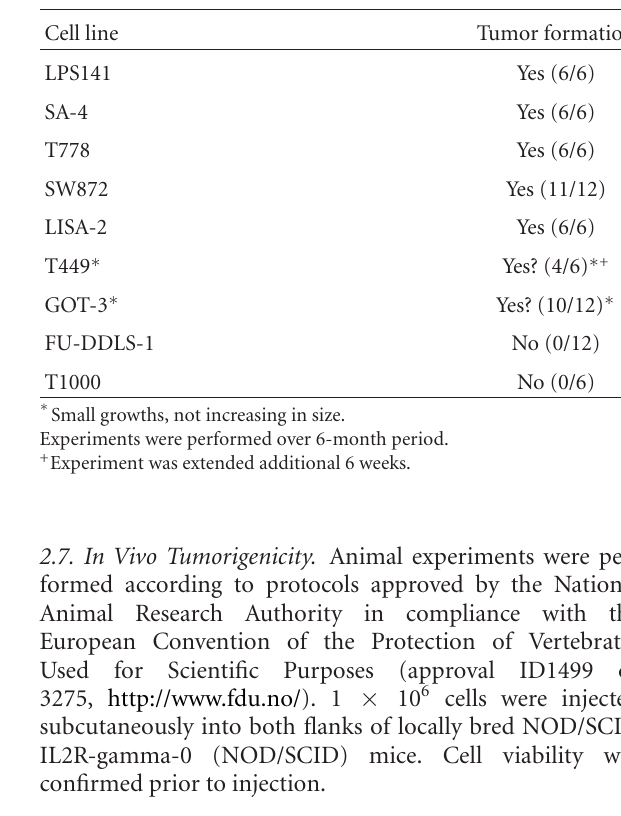
Table 1: In vivo